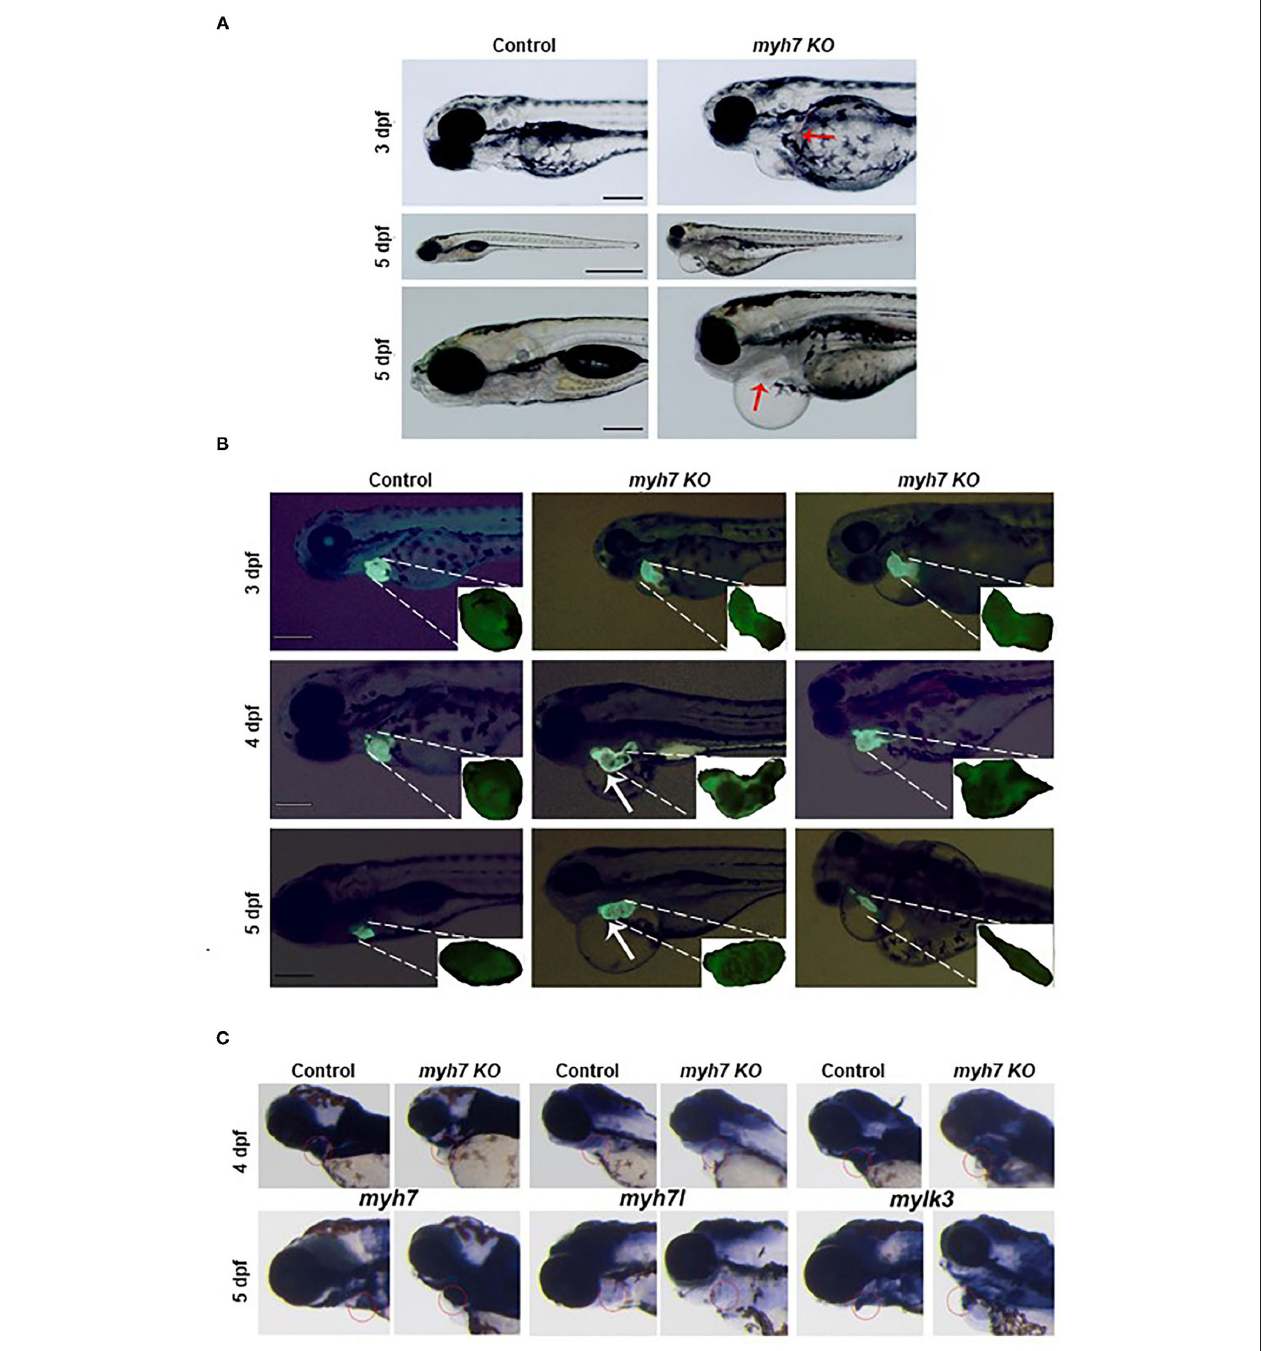
FIGURE 4 | The MYH7 deficiency causes cardiovascular defects in zebrafish. (A) Loss of MYH7 disrupts heart development. Lateral view of 3 and 5 dpf scramble gRNA injected control group and MYH7 KO larvae. Cardiac edema is clearly noticeable. Arrow at 3 dpf shows hemorrhage near heart. Edema accumulated around heart and spread to the abdominal area at 5 dpf. Arrow at 5 dpf shows enlarged heart. Scale bars: 200 µ m in 3 and 5 dpf, 1mm in middle 5 dpf. (B) The MYH7 knockout zebrafish has distorted cardiac chamber formation and looping as shown by fluorescence imaging of the Tg( actb2:hyper3 ) transgenic zebrafish reporter injected with scramble or MYH7 sgRNA. Representative images of control and mutant zebrafish are shown at 3, 4, and 5 dpf. Two different MYH7 KO fish at 3 dpf showed abnormal looping. Two different MYH7 KO fish at 4 dpf displayed enlarged and deformed ventricles. At 5 dpf, myh 7 KO fish showed enlarged and granulated ventricle. Furthermore, a MYH7 mutant zebrafish with tubular heart is shown. Scale bars: 200 µ m. (C) MYH7 is essential for proper formation of the cardiac ventricle and the pericardial cavity as shown by WMISH. Expression of MYH7, MYH7l, and mylk3 mRNAs is strongly reduced in MYH7 KO zebrafish at 4 dpf. MYH7 expression expands to the pericardial cavity and ventricular chamber in MYH7 KO fish at 5 dpf. MYH7l expression is reduced in MYH7 KO fish at 5 dpf. Expression of mylk3 in the cardiac ventricle of MYH7 KO larvae is disrupted at 5 dpf.